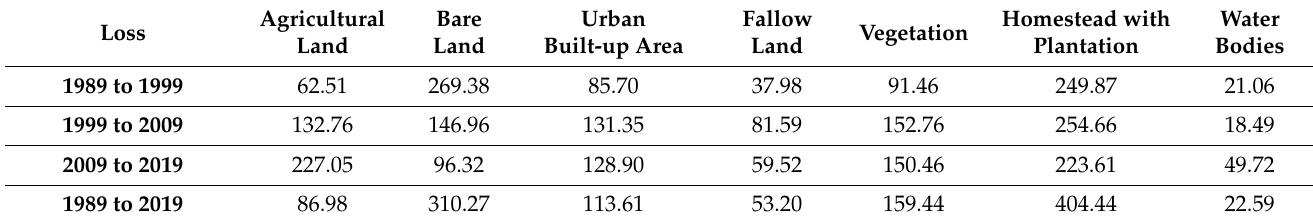
Table 12. Account for areal loss (km 2 ) per LULC elements over the